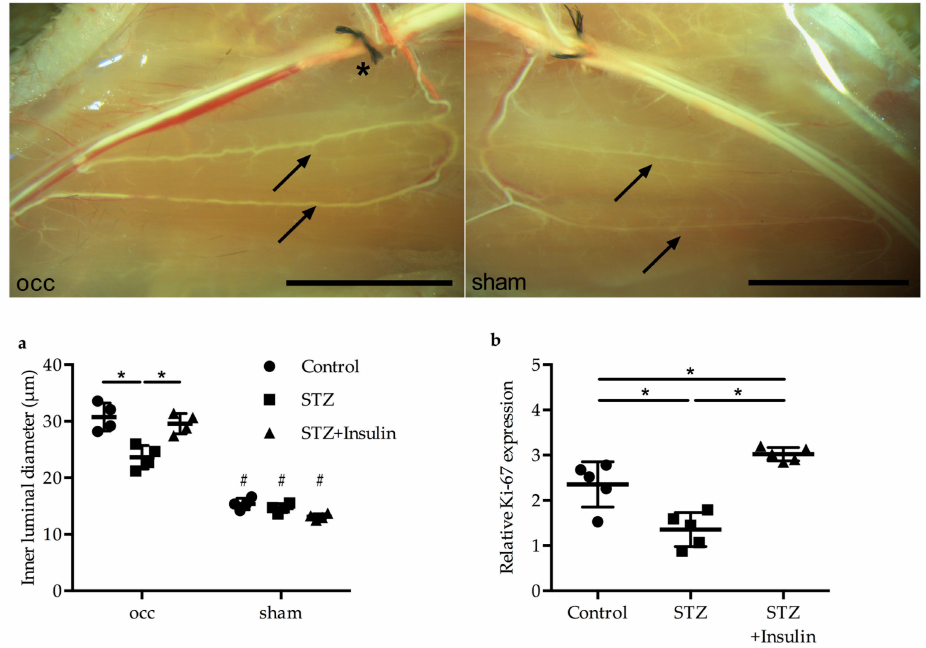
Figure 3. Upper panel: pictures of superficial collateral arteries of STZ-treated mice 7 days after femoral artery ligation (FAL, occ, left picture) or sham operation (right picture). Arrows indicate pre-existing (resting) collaterals of the sham-operated site or growth-induced collaterals of the experimental site. The ligation (*) of the femoral artery was executed downstream of the profound artery. Scale bars: 5 mm. Lower panel: ( a ) dot plots represent the inner luminal vessel diameter measured 7 days post-FAL ( n = 4 per group, at least two collateral arteries per mouse and two sections were evaluated, * p < 0.05 (each group compared to each other group), # p < 0.05 compared to the corresponding occ group using a one-way ANOVA with Bonferroni’s multiple comparison test). ( b ) Dot plots show the expression level of the proliferation marker Ki-67 in collaterals of control, STZ, and STZ + insulin-treated mice 24 h after FAL. Results were normalized to the expression level of the 18S rRNA ( n = 5 per group, * p < 0.05 (each group compared to each other group) using a one-way ANOVA with Bonferroni’s multiple comparison